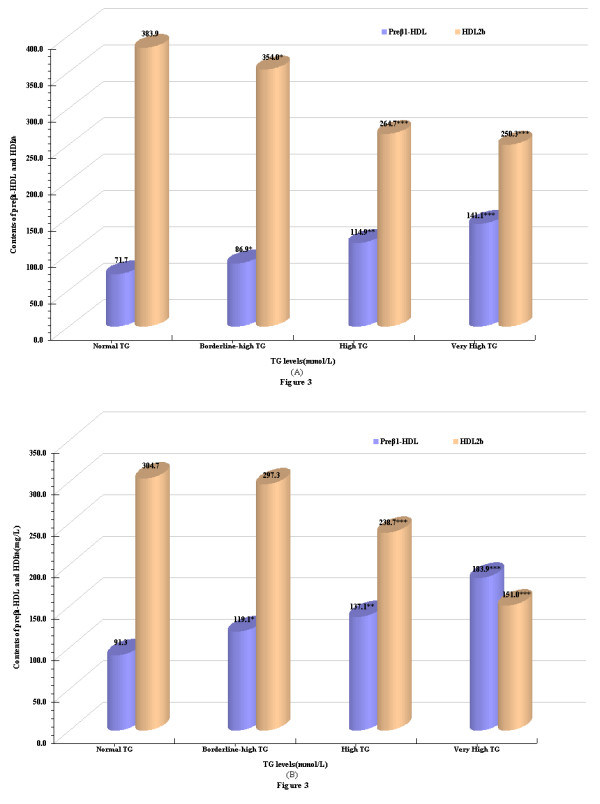
The contents of preβ1-HDL and HDL2b for TG combine with apoB-100/A-I(A) and TG combine with apoB-100/A-I(B), respectively. *P< 0.05,**P< 0.01, ***P< 0.001, compared with the normal TG subgroup